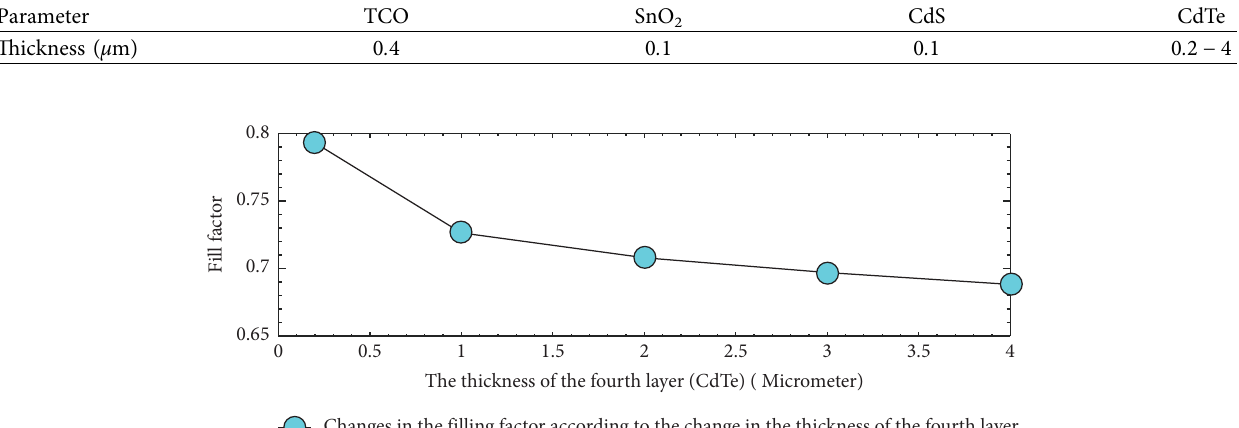
Figure 9: Graph of the flling factor according to the thickness of the CdTe layer.